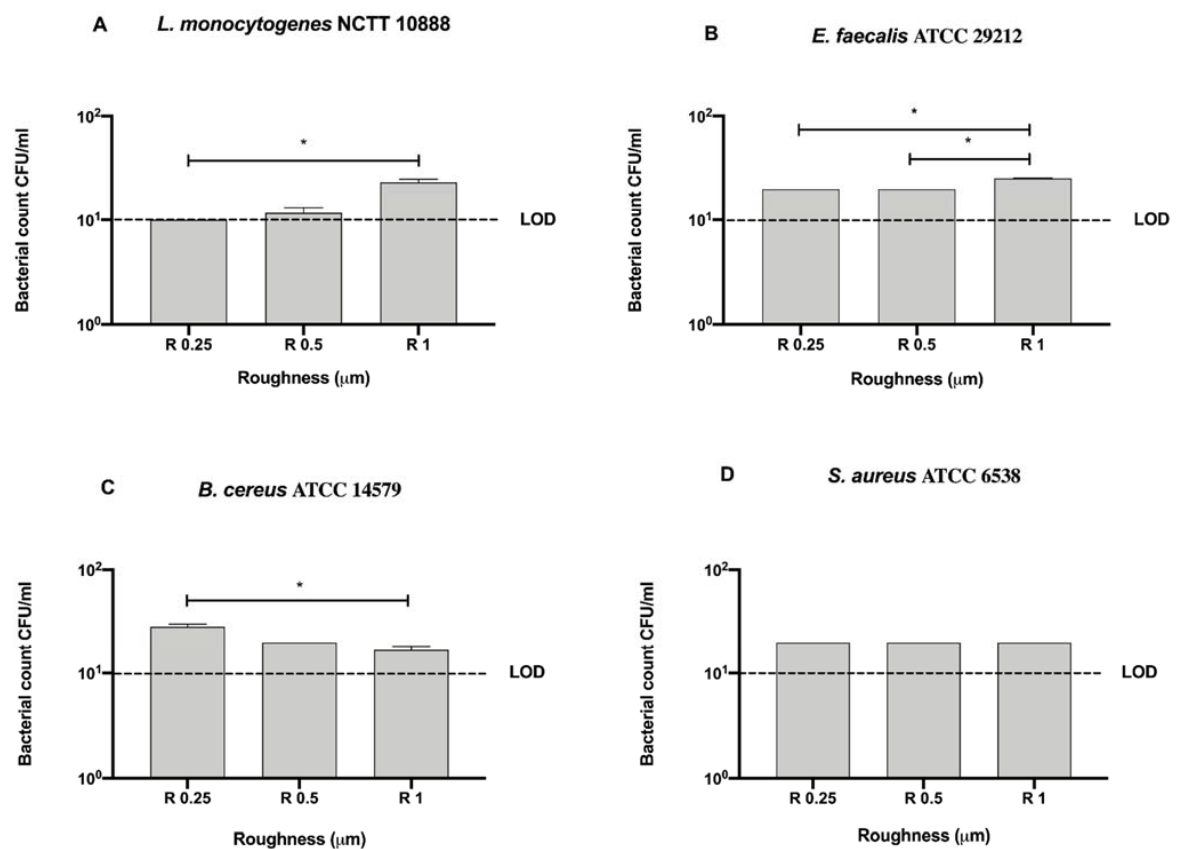
Figure 10. Graphical representation of the antibacterial activity of different surface roughness on nanoXHAM ® D-treated disks against Gram-positive bacteria ( A–D ), * p < 0.05; Limit of detection (LOD) is 10 1 (10E+1).